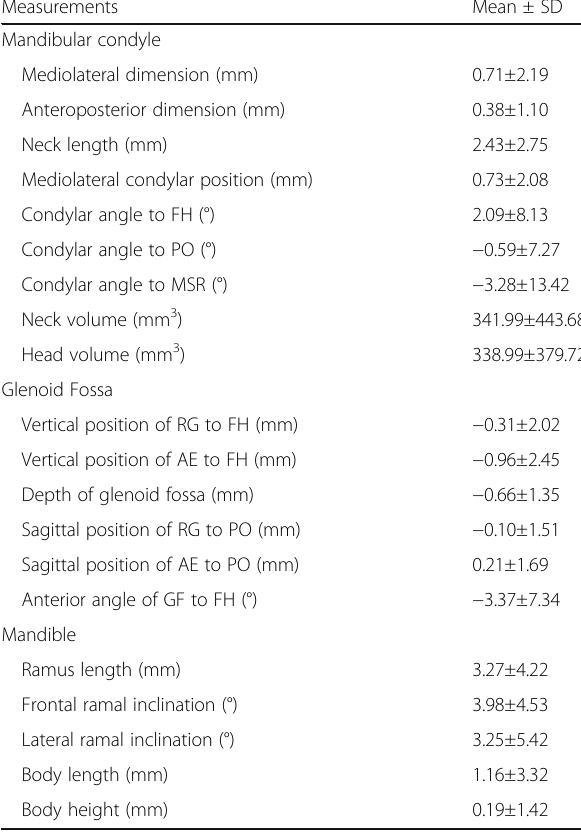
Table 4 The right/left differences of the measurements ( n = 30) Table 5 Multiple linear regression analysis between the menton deviation and the right/left differences of